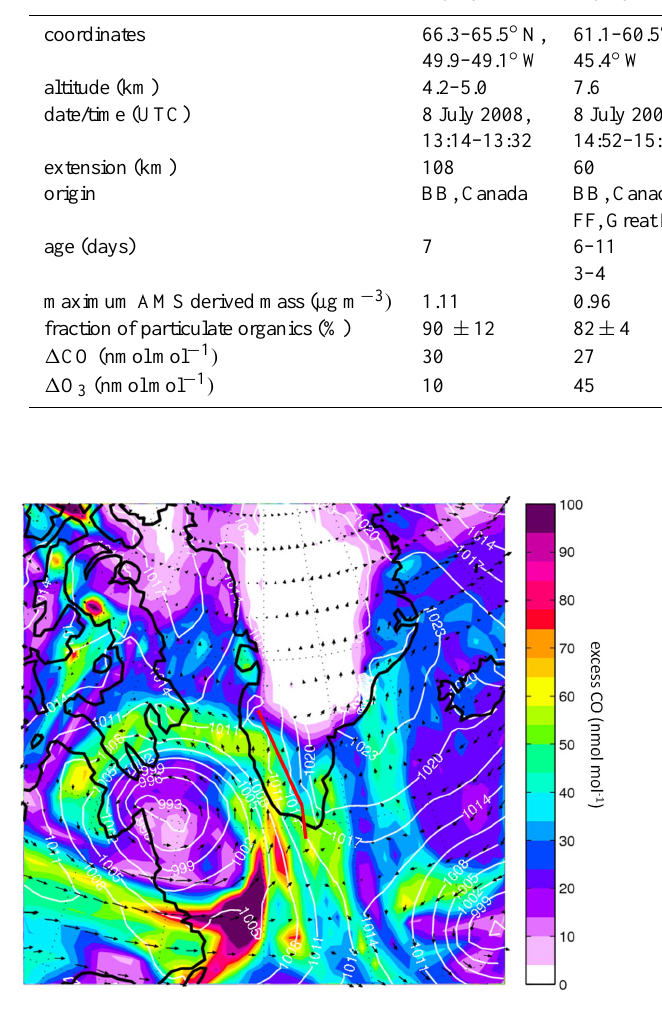
Fig. 2. Low pressure system west of Greenland on 8 July at 15:00 UTC at 5000 m altitude. The colour-code denotes FLEXPART de- rived excess CO mixing ratio in nmolmol − 1 , the white contours represent surface pressure levels from 980 to 1030hPa in 3hPa in- tervals. The red trace indicates the flight track on 8 July